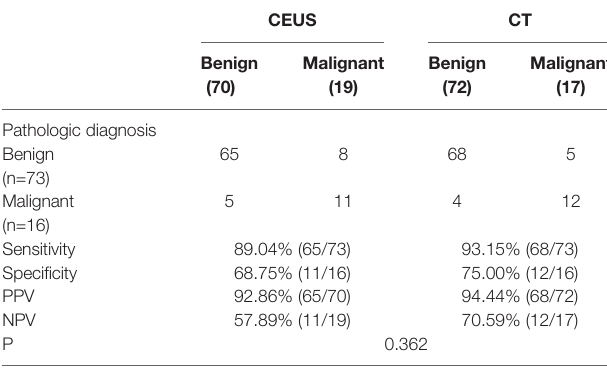
TABLE 6 | Comparison of the diagnostic accuracy of CEUS and CT in benign and malignant polypoid lesions.